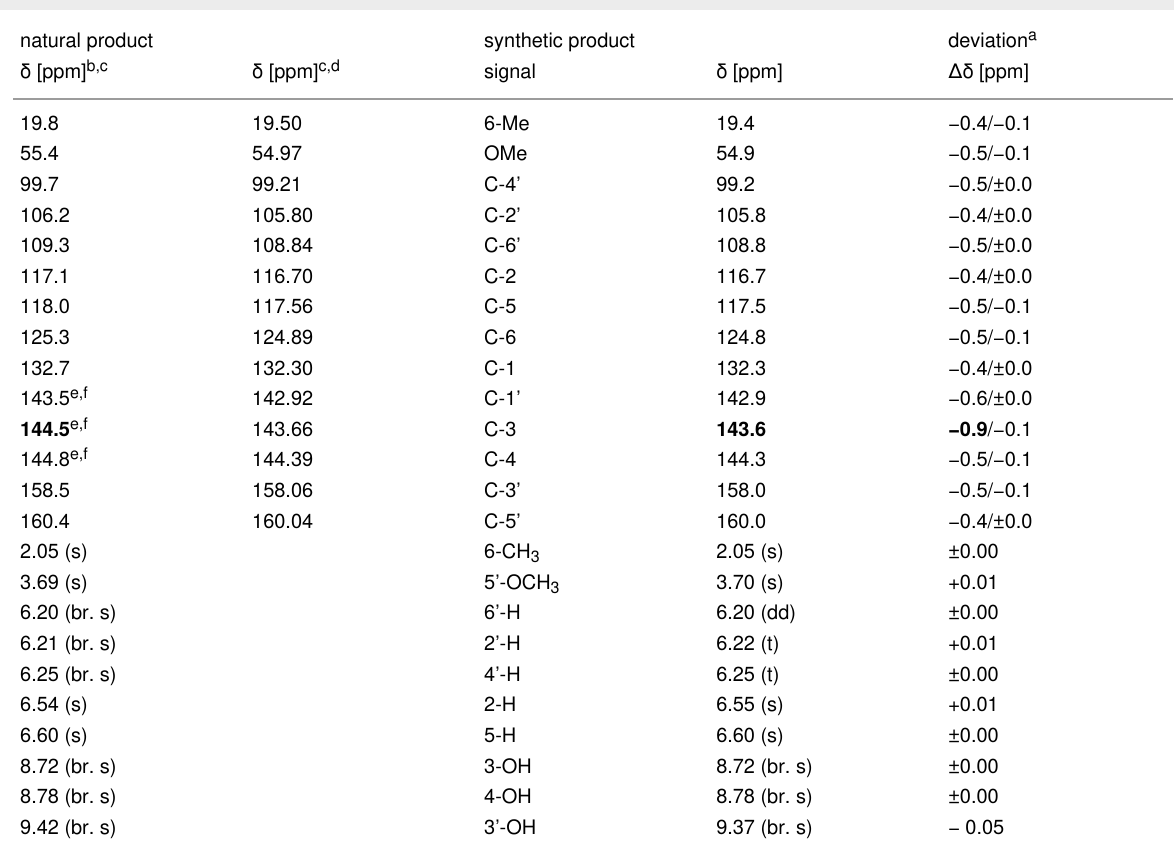
Table 1: NMR data of natural and synthetic biaryl 1 . natural